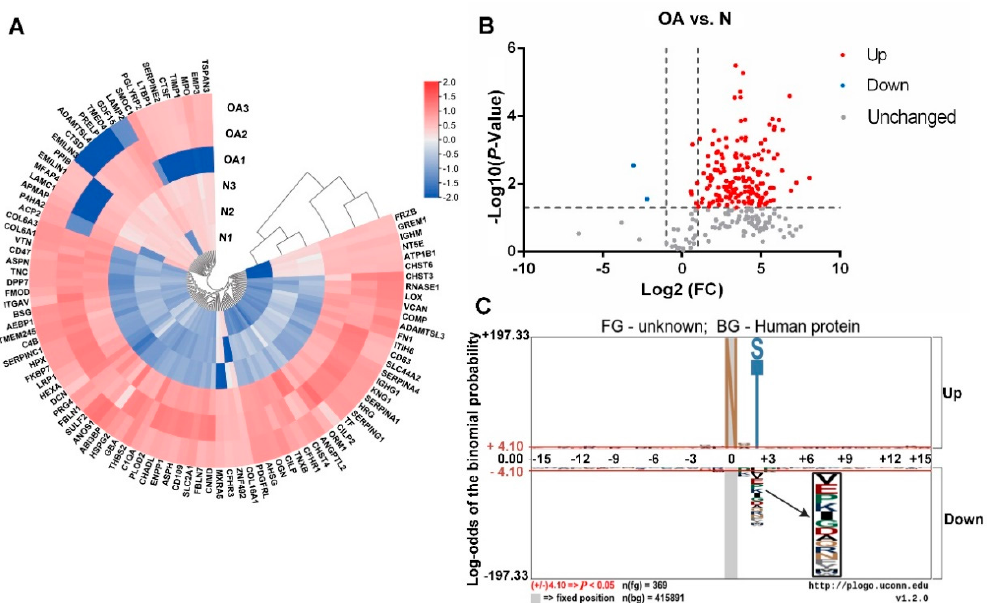
Figure 2. Heatmap, volcanic plot, and motif analysis in OA vs. N. ( A ) Heatmap of differentially expressed N-glycoproteins of knee cartilage in OA vs. N. Circular heatmap obviously classified samples into two distinct groups by clustering analysis. The comparative analysis aimed to determine whether significant differences could be found in OA vs. N. Within OA1, OA2, OA3, and N1, N2, N3, respectively, the differences were small. The overall difference in OA vs. N was significant. ( B ) Differential expression of N-glycopeptides from knee cartilage in OA vs. N. N-glycopeptides with FC ≥ 2.0 and p < 0.05 were considered as up-regulated N-glycopeptides, and those with FC ≤ 0.5 and p < 0.05 as down-regulated N-glycopeptides. Significantly, there were 167 up- and 2 down-regulated N-glycopeptides in OA vs. N. ( C ) Motif analysis of N-glycosylation modification sites in OA vs. N. Plogo-generated relative frequency plots of the significant sequence motif. It is reliable when the heights of amino acid residues are above 4.10 (that is to say when p < 0.05, the results are reliable).